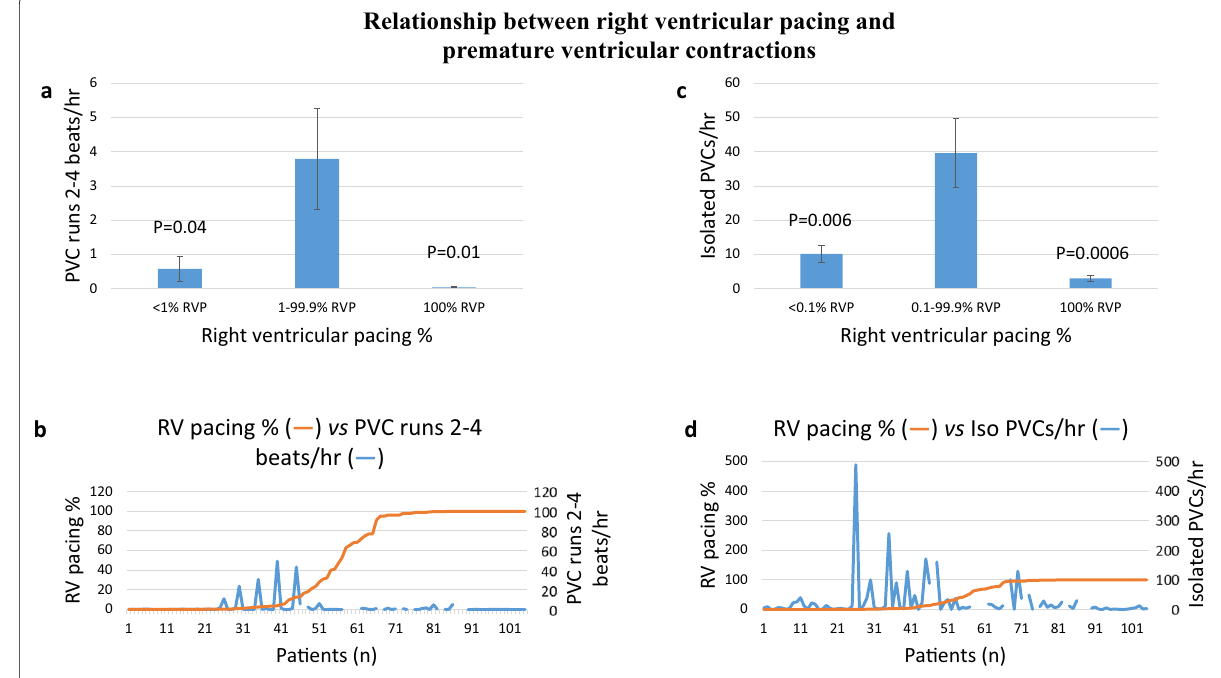
Fig. 2 Relationship between right ventricular pacing and premature ventricular contractions. a Bar graph depicting the relationship between right ventricular pacing (RVP)% ( x axis) and premature ventricular contraction (PVC) runs of 2–4 beats/h ( y axis). Note that patients with intermittent RVP (1–99.9%) had the highest burden of PVC runs which was significantly higher when compared to patients with < 1% ( p RVP ( p 0.01). b Line graph depicting the relationship between PVC runs of 2–4 beats/h (blue line; y ‑axis on the right) and RVP% (orange line; = y ‑axis on the left) for all the studied patients ( x ‑axis) aligned from left to right in increasing order of RVP%. Note the low burden of PVC runs (blue line) with < 1% (patients 1–21 on x ‑axis) and 100% RVP (patients > 91 on x ‑axis). Intermittent RVP (1–99.9%; patients between 21 and 91 on x ‑axis) dramatically increases the burden of PVC runs (blue line). c Bar graph depicting the relationship between RVP% ( x ‑axis) and isolated PVCs/h ( y ‑axis). Note that patients with intermittent RVP (0.1–99.9%) had the highest isolated PVC burden which was significantly higher when compared to patients with < 0.1% (